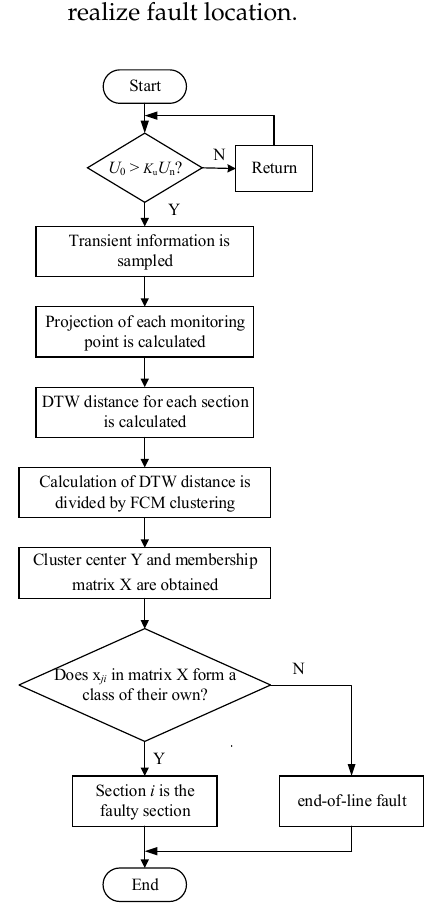
Figure 6. Flowchart of fault location.